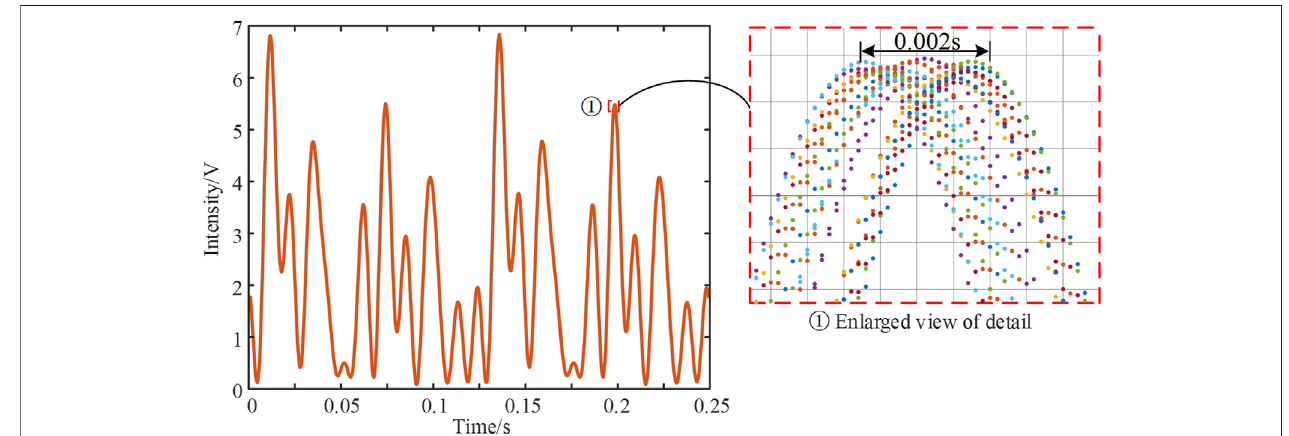
FIGURE 6 | Time repeatability error due to the synchronization error of the external trigger and the limited sampling frequency of data